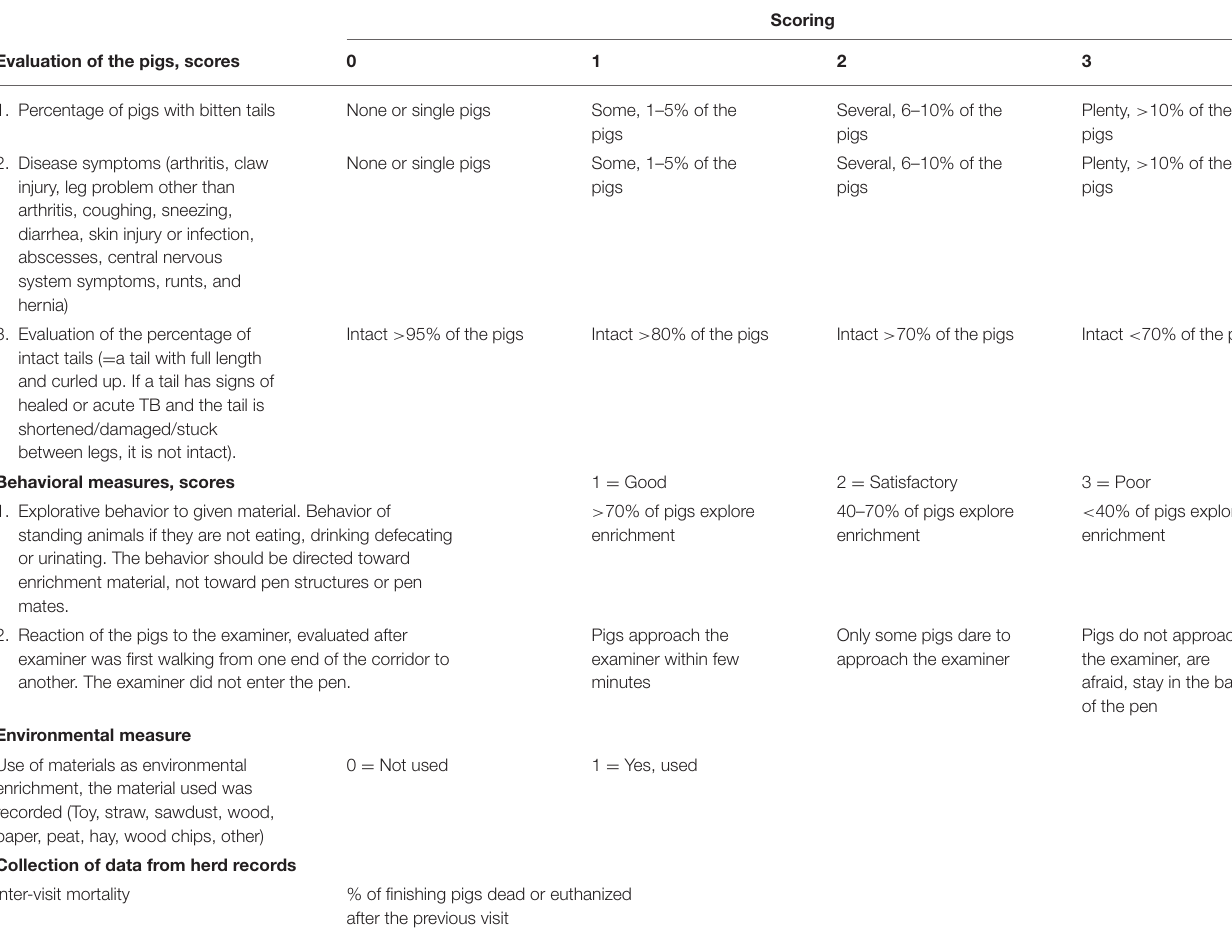
TABLE 2 | Summary of the data collected by the herd health veterinarians in finishing units of 84 herds during routine Sikava herd health visits.